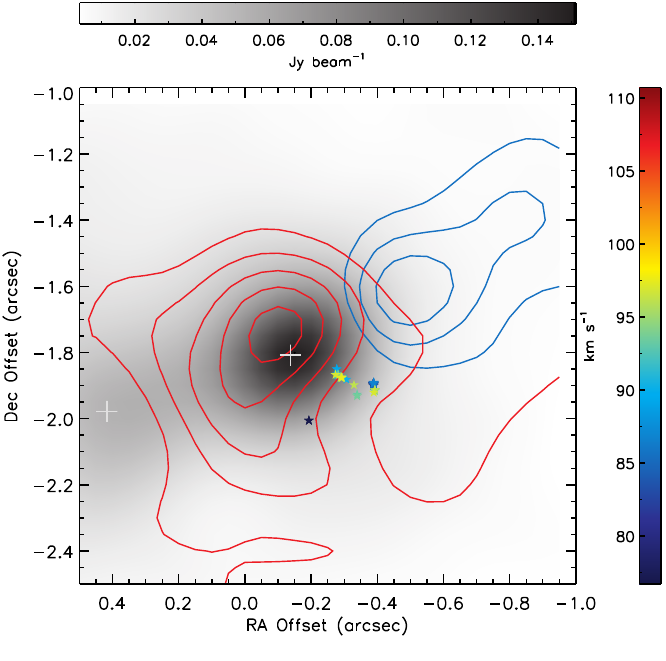
Figure 6. Spatial distribution of H 2 O masers obtained with KaVA, which are shown in colored points. Blue and red contours indicate the integrated intensity map of the SiO 5–4 line and and gray scale represents the continuum emission at 230 GHz, both of which were obtained with ALMA Band 6. Adapted from the work in [110] with permission from